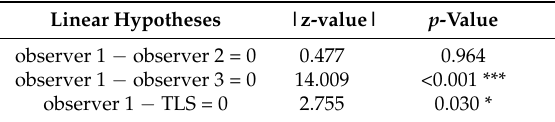
Table 1. Based on a significance level of α = 0.05, the null-hypothesis of non-systematic errors could not be rejected for two pairs (observer 1 vs. observer 2 and observer 2 vs. TLS), while it was rejected for all other pairs. Table 1. Results of the simultaneous post-hoc tests for general linear hypotheses of non-systematic deviations between CPA measurements.